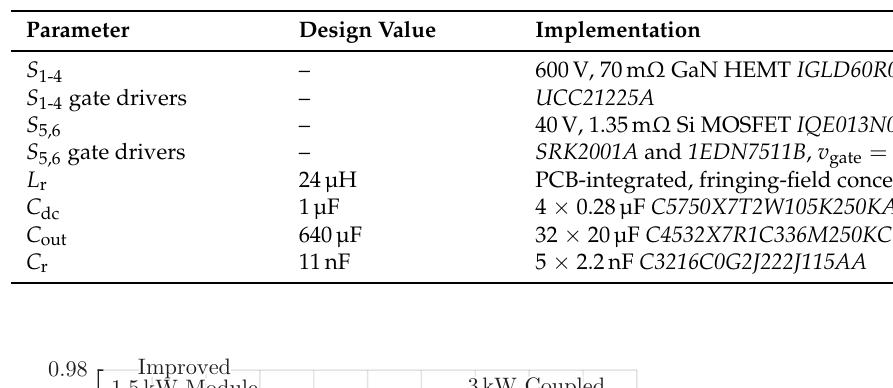
Figure 19. Next-generation DC/DC module (key values and implementations given in Table 7), measuring 89.5mm 66.0mm 13.5mm (308Win − 3 ), shown with two modules combined in an × × input-parallel output-parallel (IPOP) configuration to reach 3kW output power at 250A of output current and measuring 89.5mm 66.0mm 24.1mm (345Win − 3 ). The snake-core transformer × × enables ideal current sharing between the phases and modules with reduced core losses from the single flux path and shared transformer core between the two modules. Table 7. Key design values and implementation for components in the Improved 1.5kW hardware demonstrator of Figure 19.